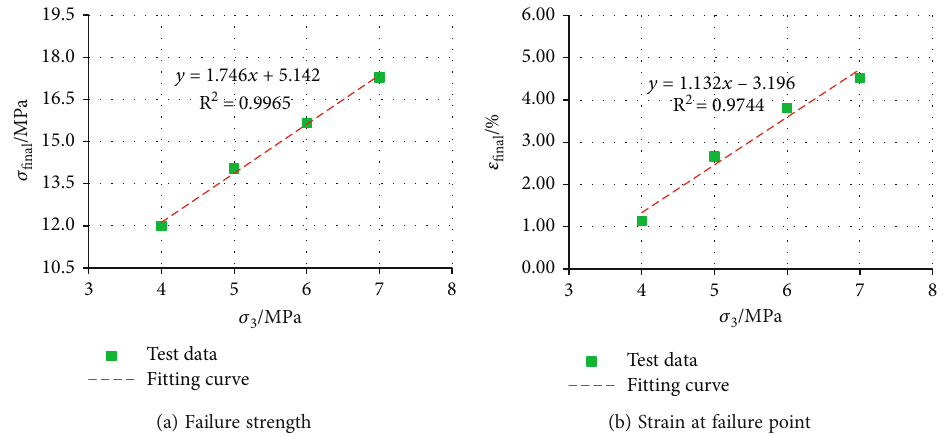
Figure 4: Strength and strain change curves at the failure point in the axial pressure unloading of coal specimens under a constant atmospheric pressure of 1.5MPa and di ff erent con fi ning pressures.